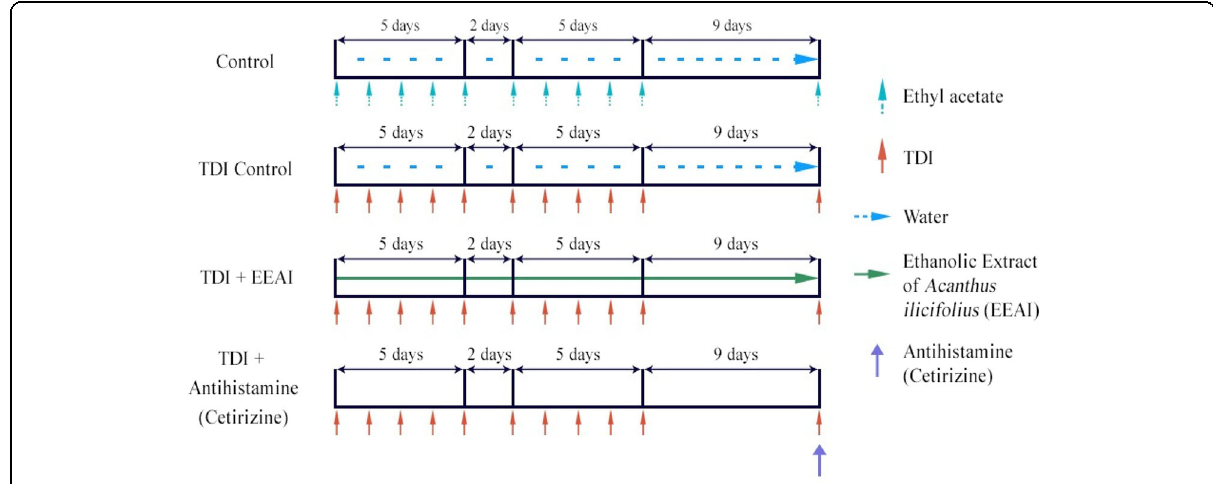
Fig. 1 Experimental protocol for nasal allergy model mice in antiallergic